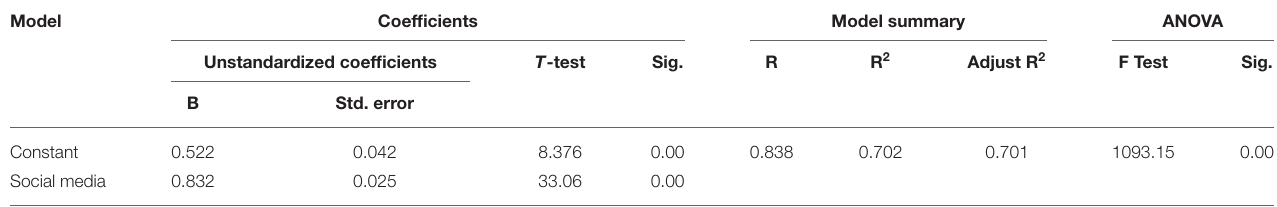
TABLE 6 | The effects of social media platforms on panic buying among consumers during the COVID-19 pandemic in Iraqi Kurdistan.